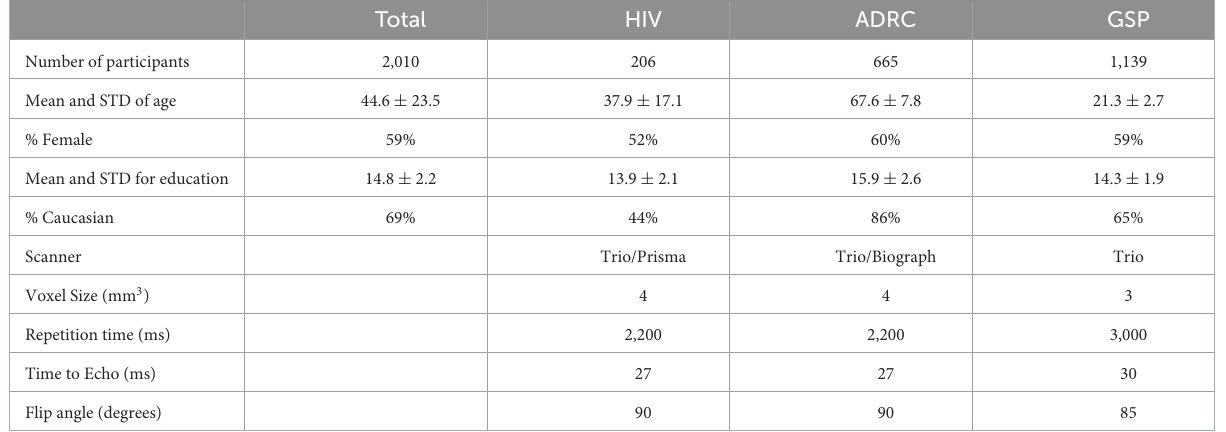
TABLE 1 Characteristics of training